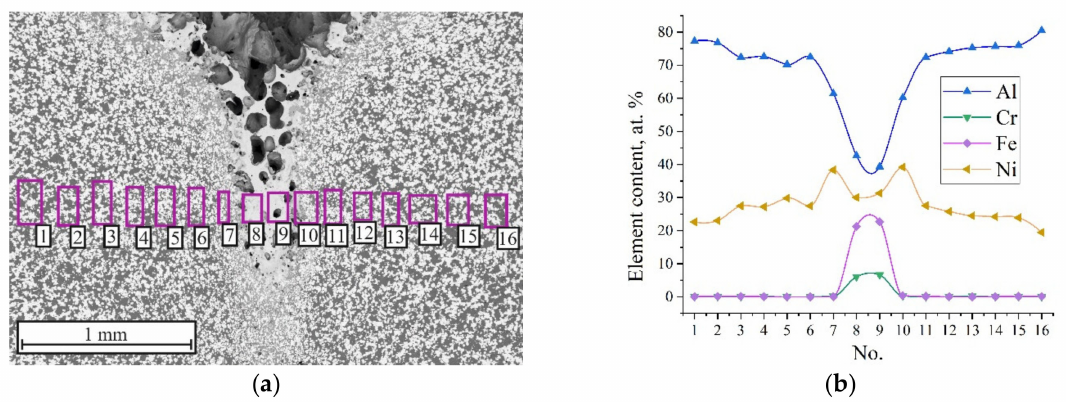
Figure 11. SEM image of transition region in the powder sample (segment II): ( a ) SEM image of central part; ( b ) element distribution after EDS analysis (from point 1 to point 16).